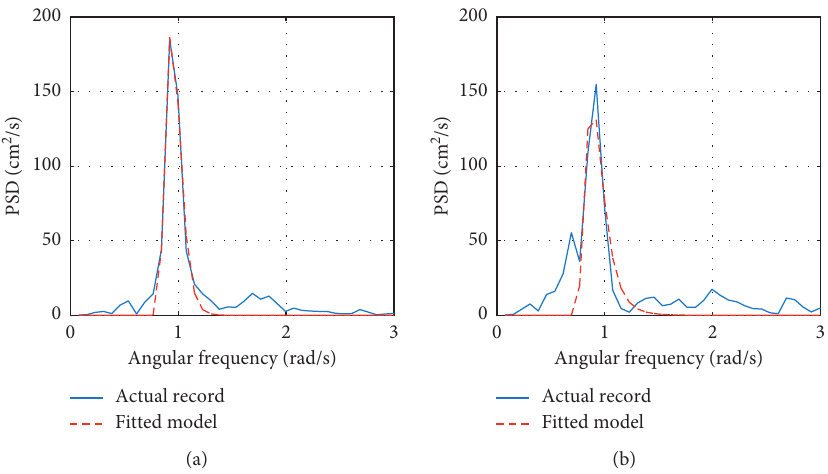
Figure 5: PSD for truncated LALP velocity time series. (a) CHB002EW and (b) TKY023EW.